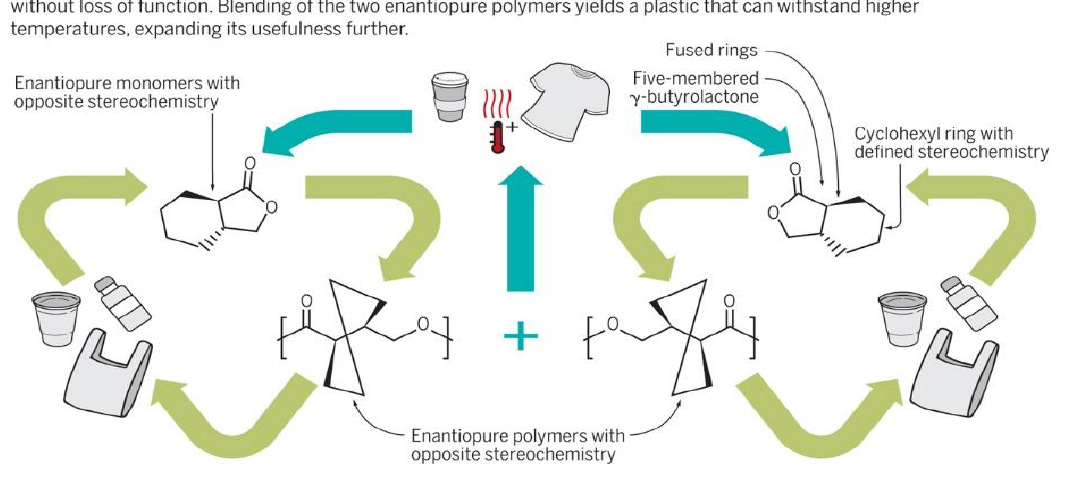
Figure 1: Repeatedly recyclable polymers